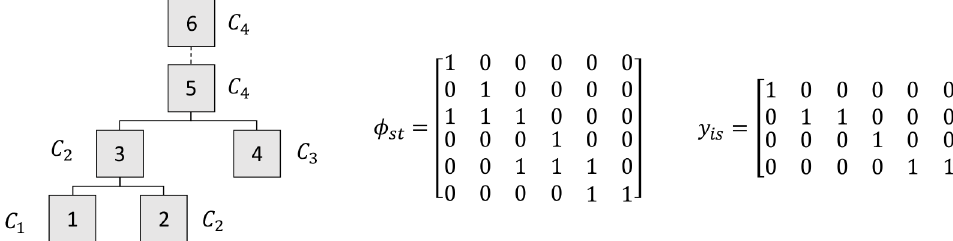
Figure 4. An example illustrating Φ